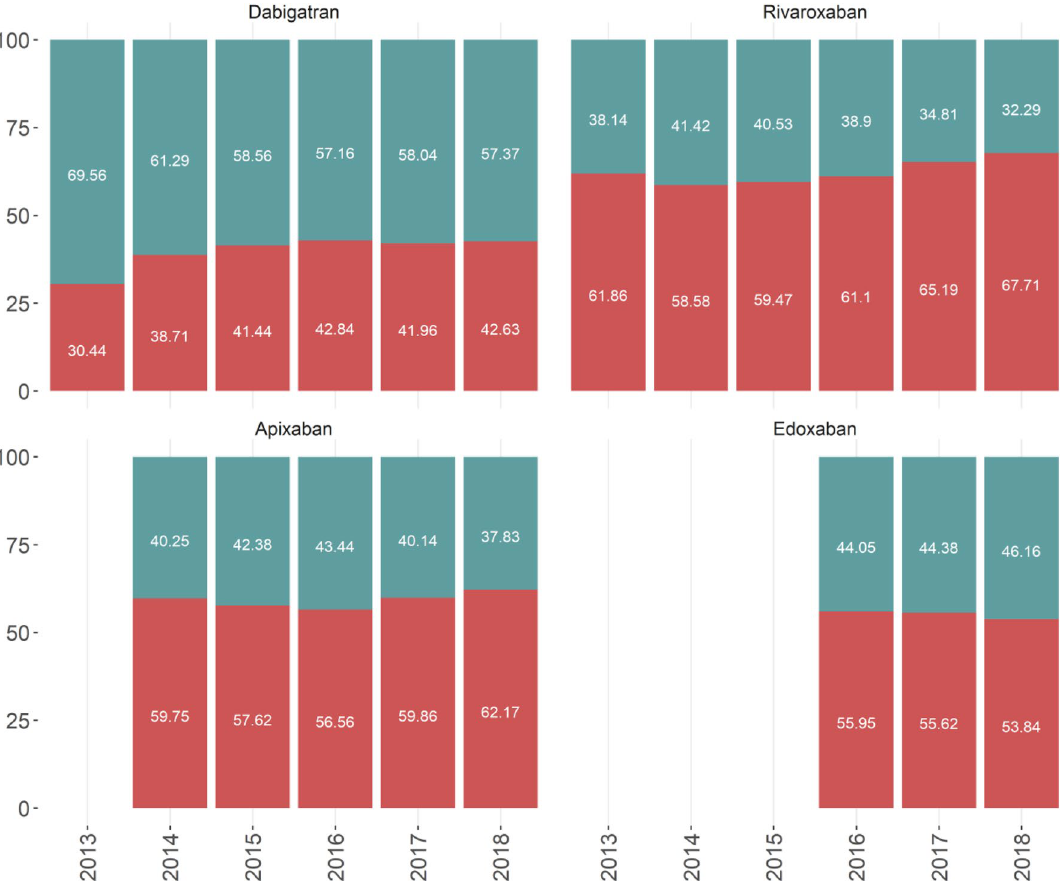
Figure 3. Differences in proportions of dosage choice among 927,523 NOAC treatments based on year of first prescription (2013–2018) in AIFA Registry. Red bars refer to proportion of patients on standard dose of NOACs; green bars refer to adjusted dose of NOACs. Plot has been made using the statistical software R 8 the ggplot2 package 10